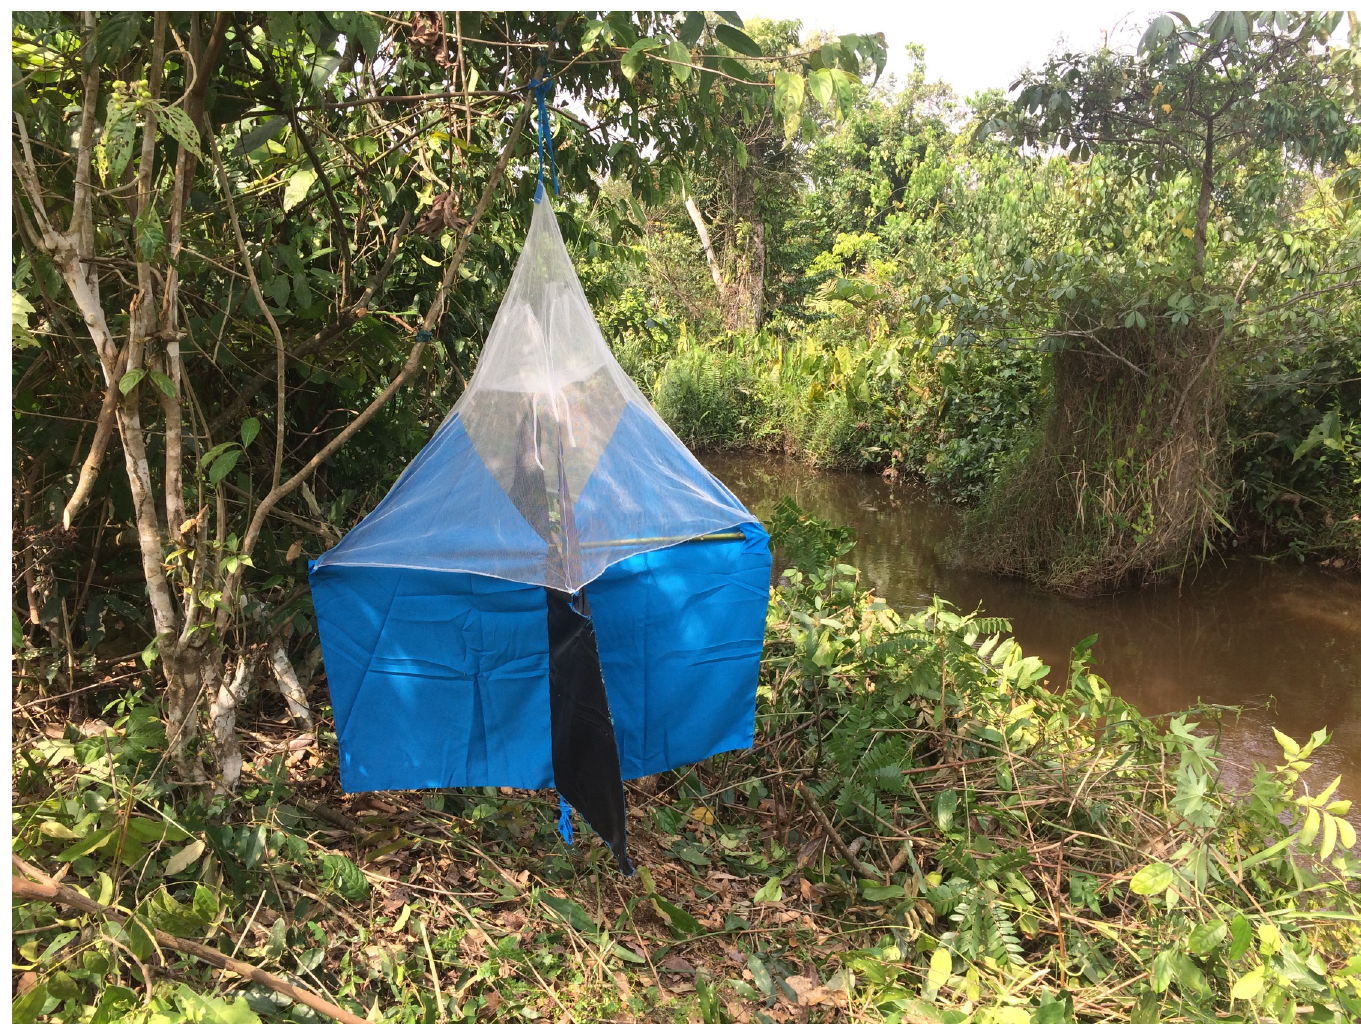
Fig 1. Tsetse Trap deployed to measure fly density before Tiny Targets deployment. (Credit: